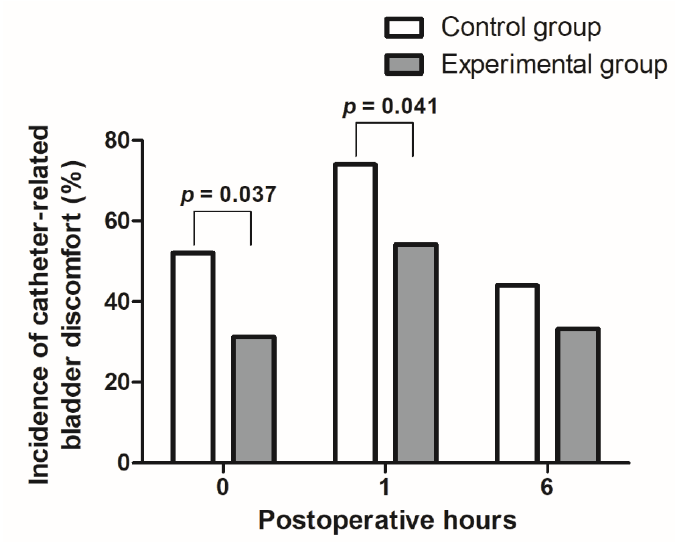
Figure 2. Comparison of catheter-related bladder discomfort incidences after surgery between the control and experimental groups. Table 3. Comparison of the grade of catheter-related bladder discomfort after surgery between the control and experimental groups.